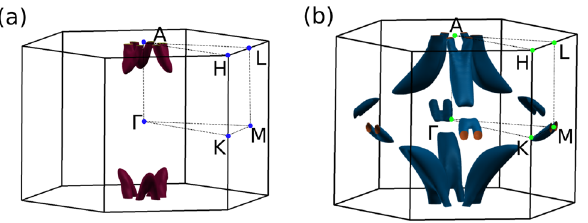
Figure 3. DFT Fermi surfaces for BaSn 2 : ( a ) for P = 0 GPa (T1), it presents a snake-like nodal line around the